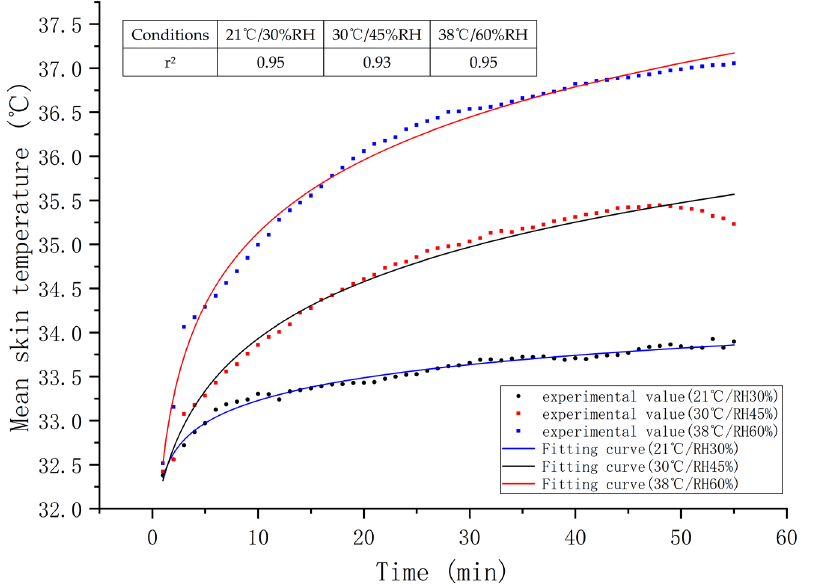
Figure 4. The weighted mean skin temperatures and logarithmic fitting curves versus time under three conditions, and high values of r 2 indicate goodness of fit.